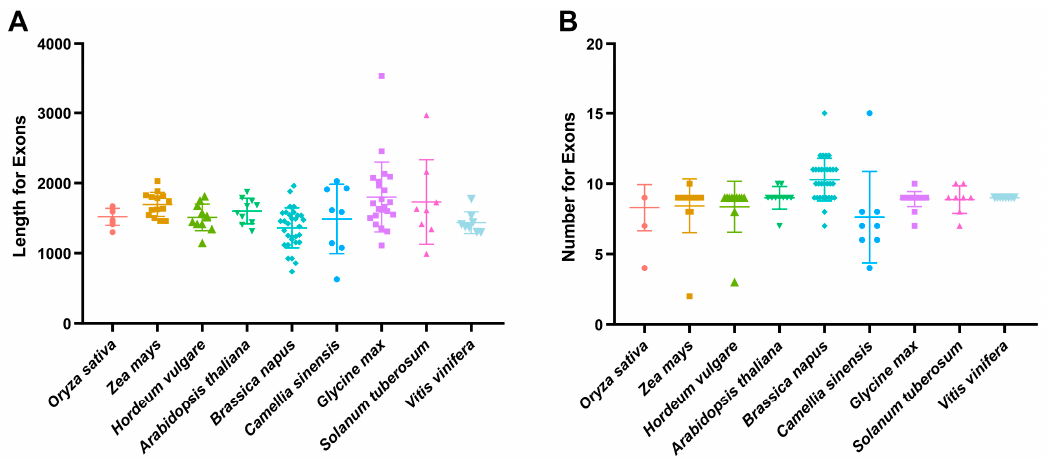
Figure 1. Comparative analysis of exons and introns between monocotyledons and dicotyledons. ( A ) Exon length of SnRK2 genes in nine species. ( B ) Exon number of SnRK2 genes in nine species.